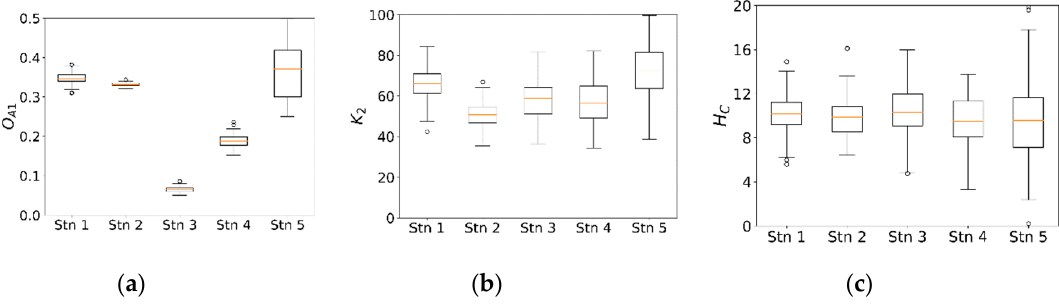
Figure 13 . Ranges of two most sensitive parameters (( a ) and ( b )) and one least sensitive parameter ( c ) developed from 100 different initial parameters using the shuffled complex evolution (SCE) algorithm